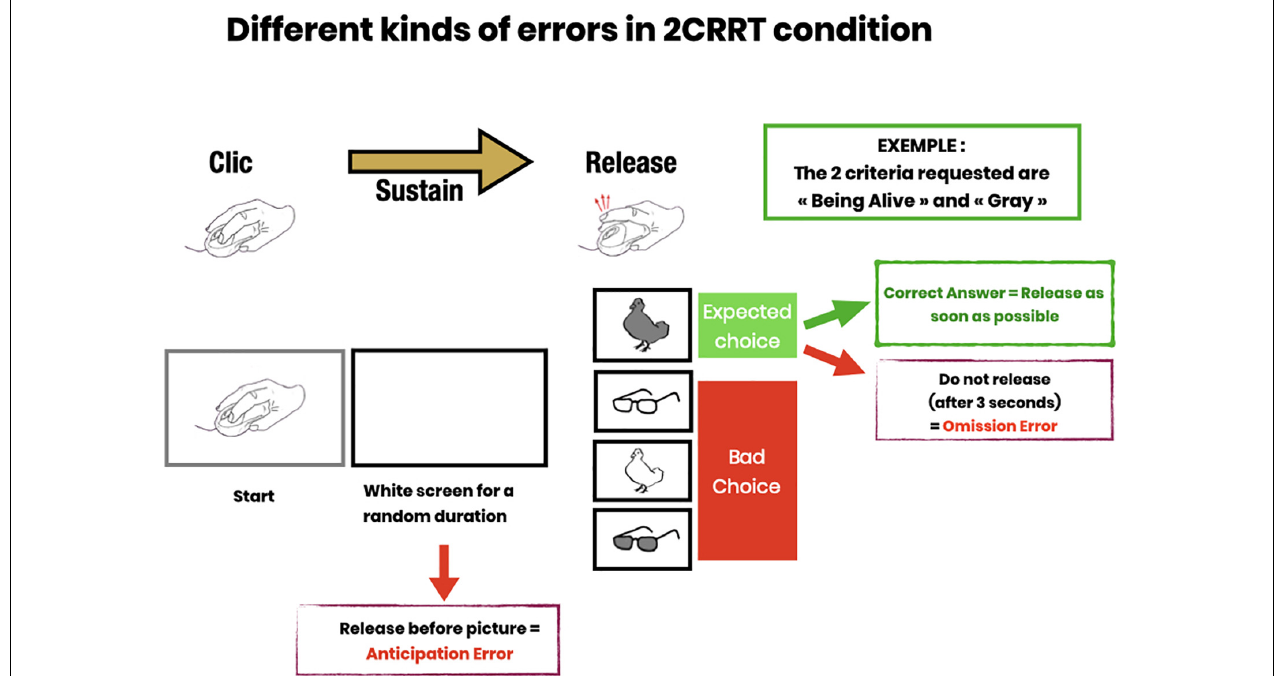
FIGURE 2 | Description of error subtypes. Anticipatory errors (subject releases pressure on the mouse button before the image appears); Omission errors (subject does not release within 3 s after image presentation); Choice errors (subject responds to the wrong category).